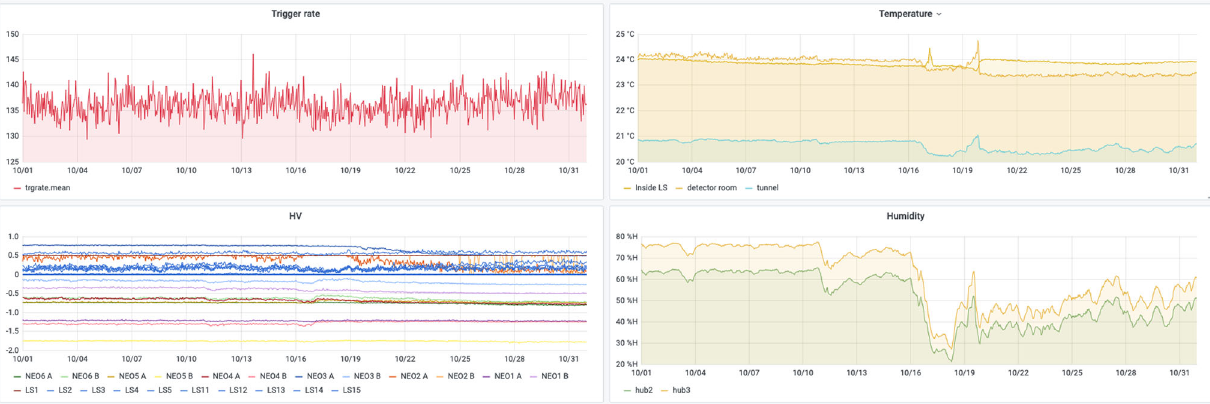
Fig. 22 Example of the slow monitoring panels recorded during October 2021. Trigger rate, temperatures, high voltages, and humidities are shown in this